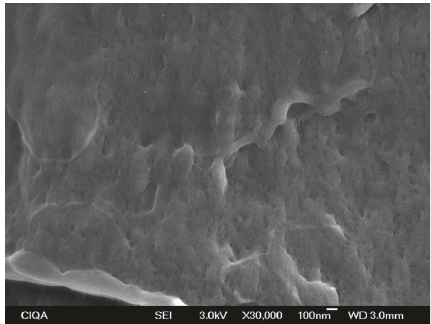
Figure 2: Fractured surface of the nylon